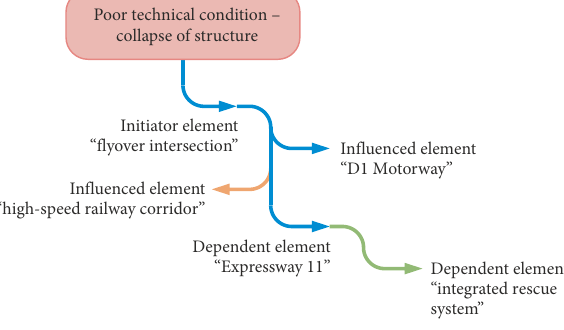
Table 6. Calculated link intensity